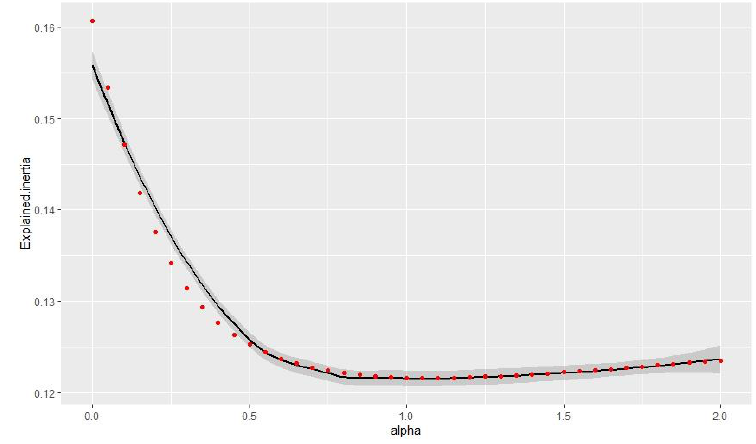
Figure 4. The relationship between the alpha value and explained inertia.